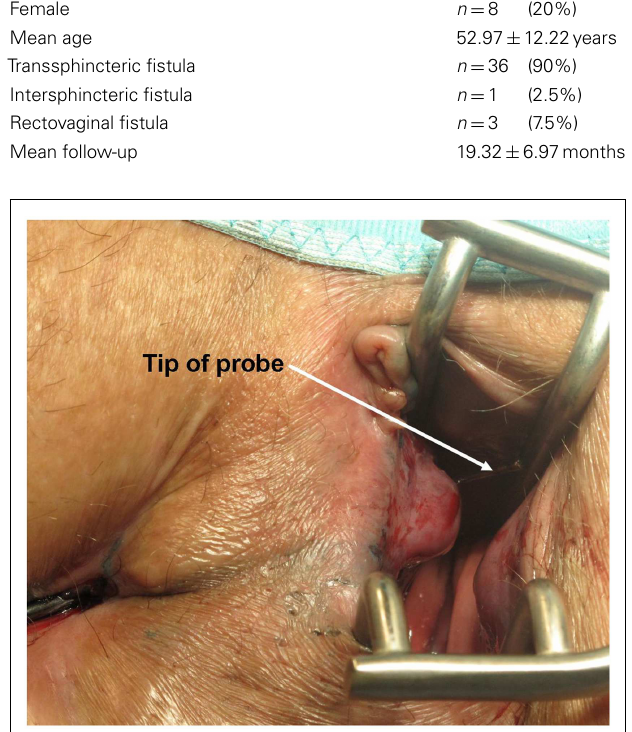
FIGURE 1 | Marking of the complex anal fistula with a flexible metallic probe .